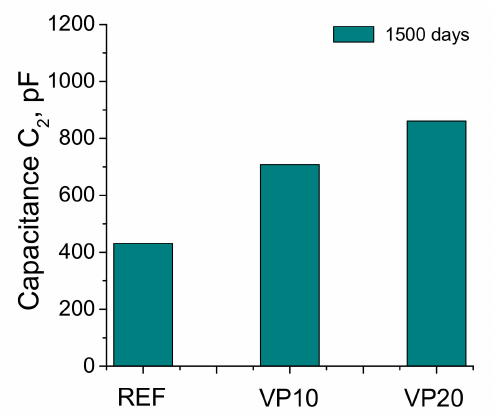
Figure 7. Capacitance C 2 values for the REF, VP10 and VP20 specimens.